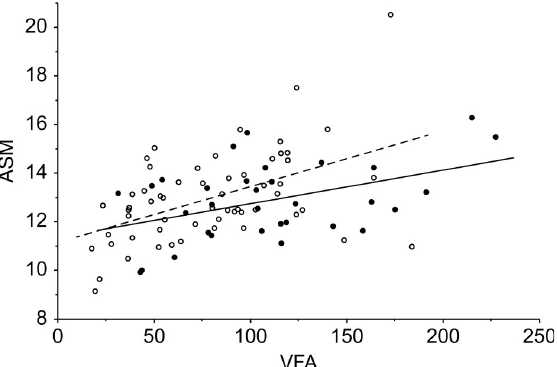
Fig 2. The correlation between VFA and ASM (not corrected for body size) among patients with high and low cardiovascular risk. Black spots and solid lines represent patients with two or more metabolic risk factors. White spots and broken lines represent patients with one or fewer risk factors.